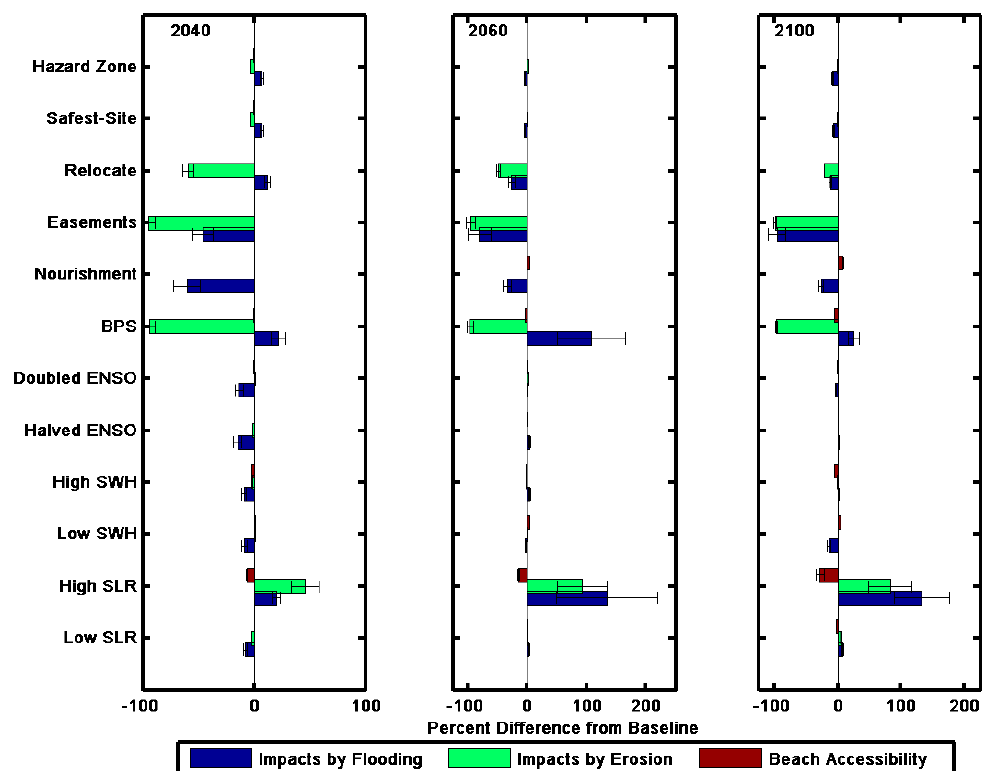
Figure 9. Beach accessibility through time under each of the six policy drivers (panels a – f ). Dashed lines indicate the decadal mean of all simulations. Bounds represent the minimum and maximum decadal means.